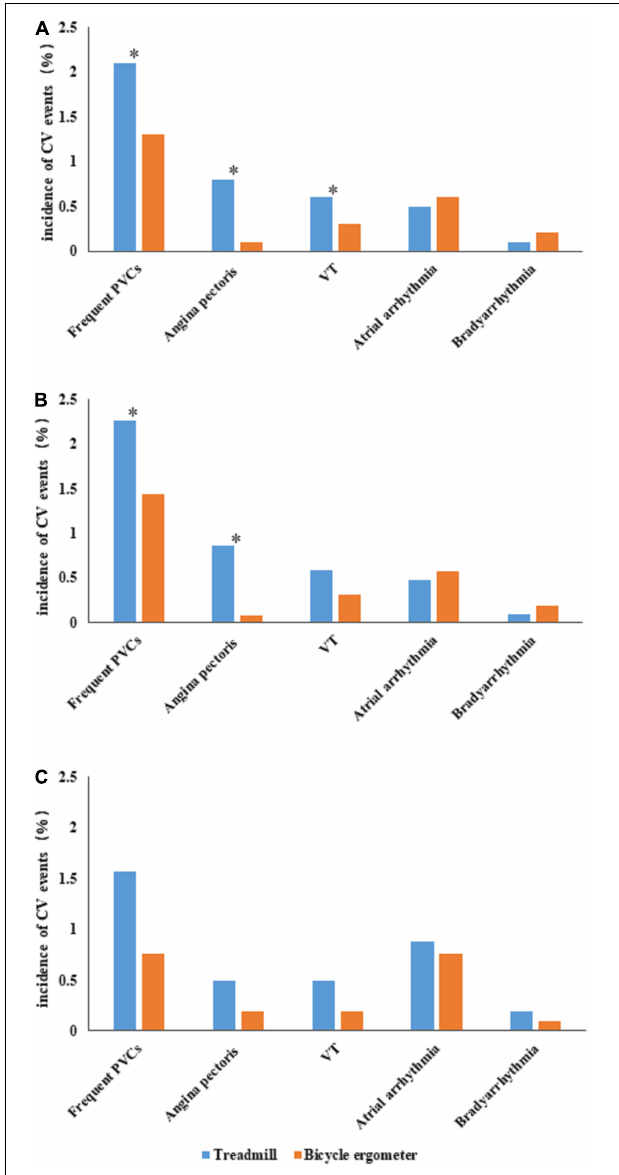
FIGURE 1 | Comparison of cardiovascular (CV) events between the treadmill group and bicycle ergometer group. (A) Depicts the incidences of various CV events in the two groups. (B) Depicts the incidences of various CV events in the male subjects of the two groups. (C) Depicts the incidences of various CV events in the female subjects of the two groups. The “ ∗ ” symbol indicates a significant difference in the incidence of CV events between the two groups ( P < 0.05). CV, cardiovascular; PVCs, premature ventricular contractions; VT, ventricular